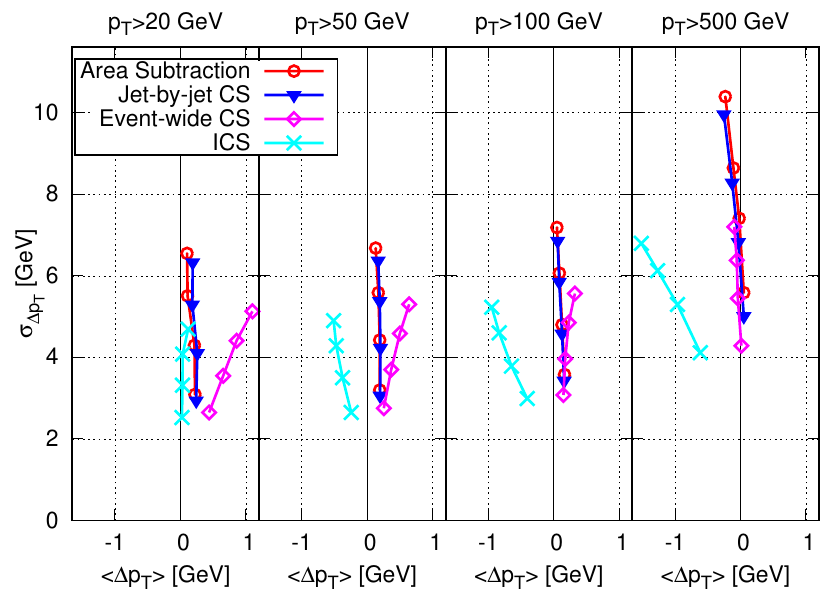
Figure 7. Comparison of the jet p T resolution as a function of jet p T bias for the Area Subtraction, jet-by-jet CS, Event-wide CS and ICS methods. Dijet events are used with di(cid:11)erent jet p T cut in each panel. Each curve corresponds to a di(cid:11)erent method and the 4 points on each curve correspond to N PU = 30, 60, 100 and 140 from bottom to